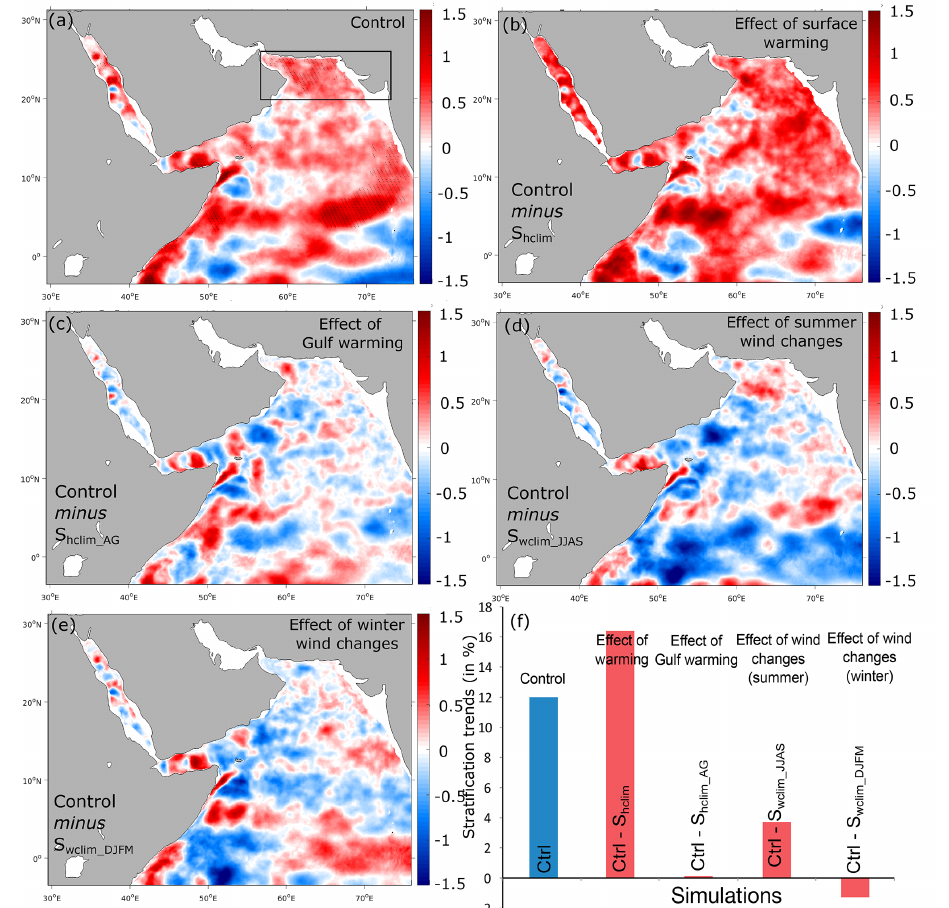
Figure 9. Effects of different atmospheric forcing perturbations on upper-ocean vertical stratification. (a) Linear trends in vertical stratifi- cation at 100m in the control run (in gm − 4 per decade). (b–e) Difference in trends in stratification at 100m between the control run and the S hclim (i.e., effect of warming), S hclim_AG (i.e., effect of Gulf warming), S wclim_JJAS (i.e., effect of summer wind intensification) and S wclim_DJFM (i.e., effect of winter wind changes) sensitivity simulations (in gm − 4 per decade). (f) Difference in stratification trends in the northern AS box between the control and the different sensitivity simulations (in percent of the mean stratification over the 1982–2010